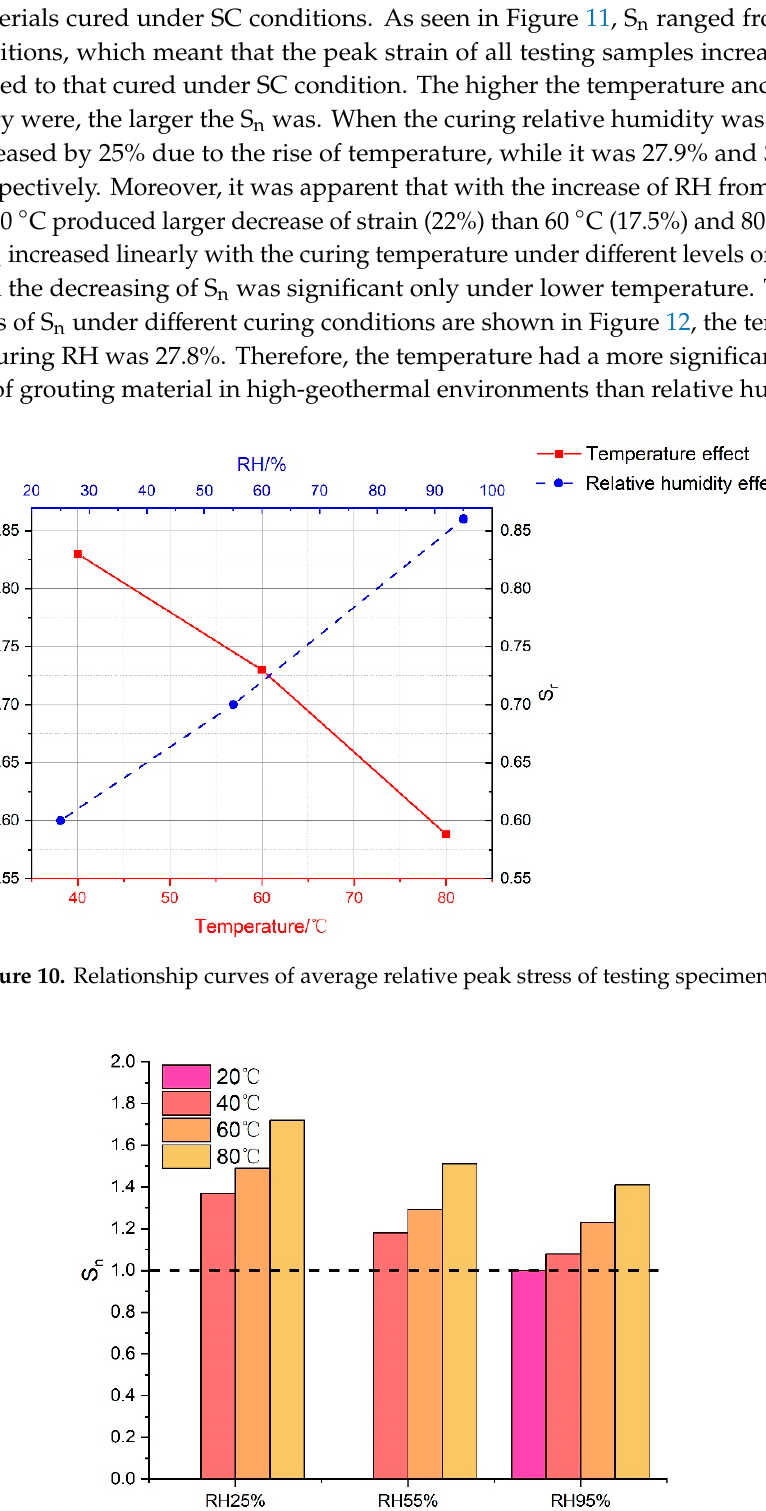
Figure 12. Relationship curves of average relative peak strain of testing specimens. 3.2.3. Quantitative Relationship between Curing Conditions and Relative Stress-Strain To further study the interactions between typical curing conditions (temperature and RH) in high-geothermal environments and long-term compressive stress and strain of cement-based grouting material, the method of multi variable nonlinear regression analysis was selected. Temperature (T) and humidity (H) are considered as independent variables, S r and S n are taken as the dependent variables, and the relationship is defined by means of the following equation: S = 𝑎 (cid:2869) 𝑇 (cid:2870) + 𝑎 (cid:2870) 𝐻 (cid:2870) +𝑎 (cid:2871) 𝑇𝐻+𝑎 (cid:2872) 𝑇+𝑎 (cid:2873) 𝐻+𝑎 (cid:2874)